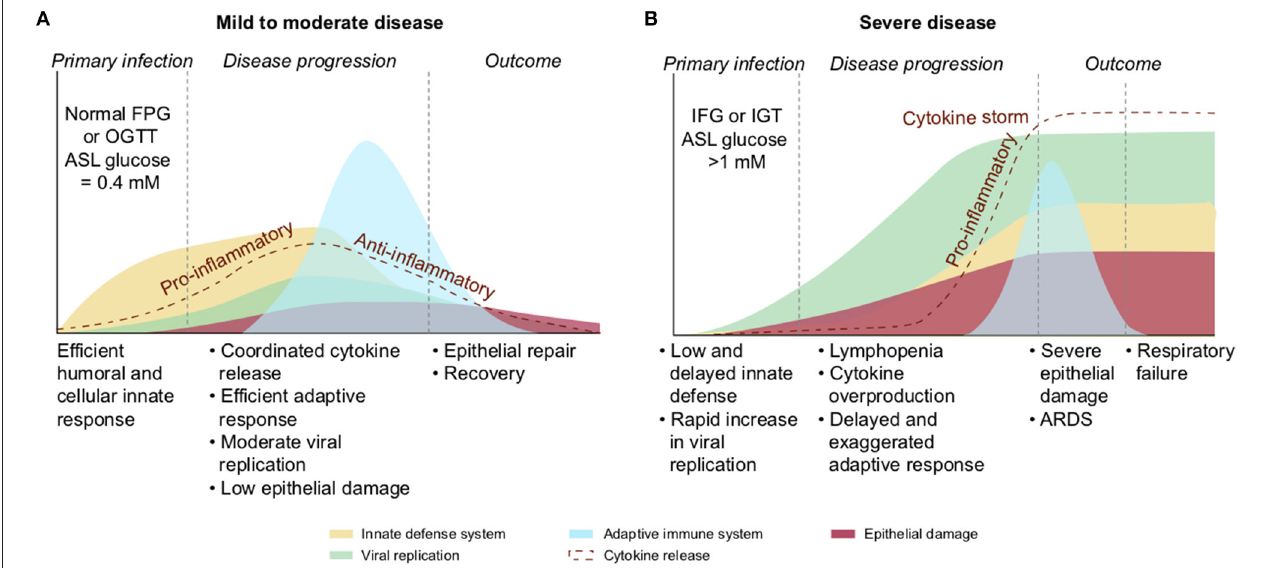
FIGURE 25 | Schematic of the immune response in a patient with normal glycemia or with hyperglycemia or IGT. (A) The efficient humoral and cellular innate defense of the lung (antimicrobial agents, phagocytes, DC cells, and NK cells) leads to a high phagocytotic rate of the viruses, resulting in a low primary viral replication rate and limiting epithelial damage. The pro-inflammatory signal targeted by the innate immune cells and the infected epithelial cells allows the recruitment of the adaptive immune system (T-cells and B-cells) for further viral clearance. The pro-inflammatory cytokines production is well-balanced by the anti-inflammatory secondary response to resolve inflammation. Viruses are finally cleared, and epithelial damages are limited. (B) In case of high glucose in ASL due to high blood glucose and/or increased epithelial permeability, the humoral and cellular innate defenses of the lung are strongly impaired, reducing the primary viral clearance and delaying the pro-inflammatory signal. The inefficient primary viral elimination response leads to a rapid increase in viral replication as well as important epithelial cellular damage, combined with a delay in the signal for the adaptive response. Additionally, high blood glucose is linked to exaggerated pro-inflammatory cytokine production as well as an impaired anti-inflammatory secondary response, together responsible for the cytokine storm. The cytokine overproduction and the important cellular damages are leading to development of ARDS and eventually respiratory